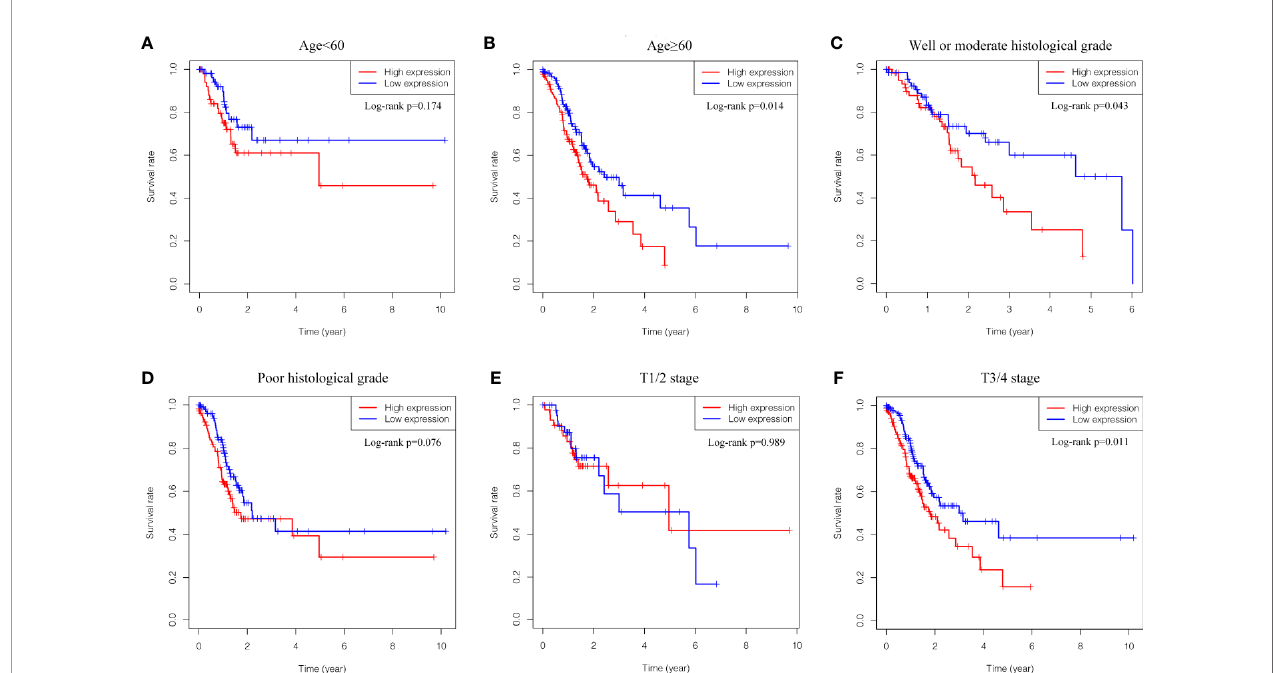
FIGURE 3 | Relationship between GUCY1A2 expression and OS in different subgroups of clinicopathological parameters. (A) OS curve of GC patients with age<60 ( P = 0.174); (B) OS curve of GC patients with age ≥ 60 ( P = 0.014); (C) OS curve of GC patients with well or moderate histological grade ( P = 0.043); (D) OS curve of GC patients with poor histological grade ( P = 0.076); (E) OS curve of GC patients with T1/2 stage ( P = 0.989); (F) OS of GC patients with T3/4 stage ( P = 0.011). OS, overall survival; GC, gastric